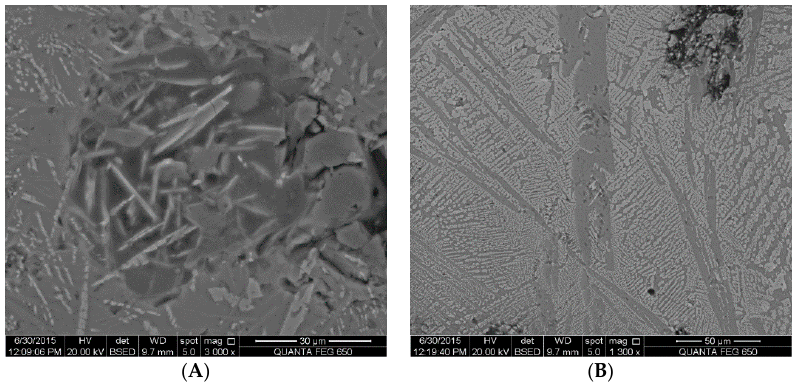
Figure 12. Rod-like stacks crystals and lamellar stacks crystals in 80%-O 2 slag, SEM back scattering images. ( A ) Rod-like stacks crystals; ( B ) Lamellar stacks crystals.